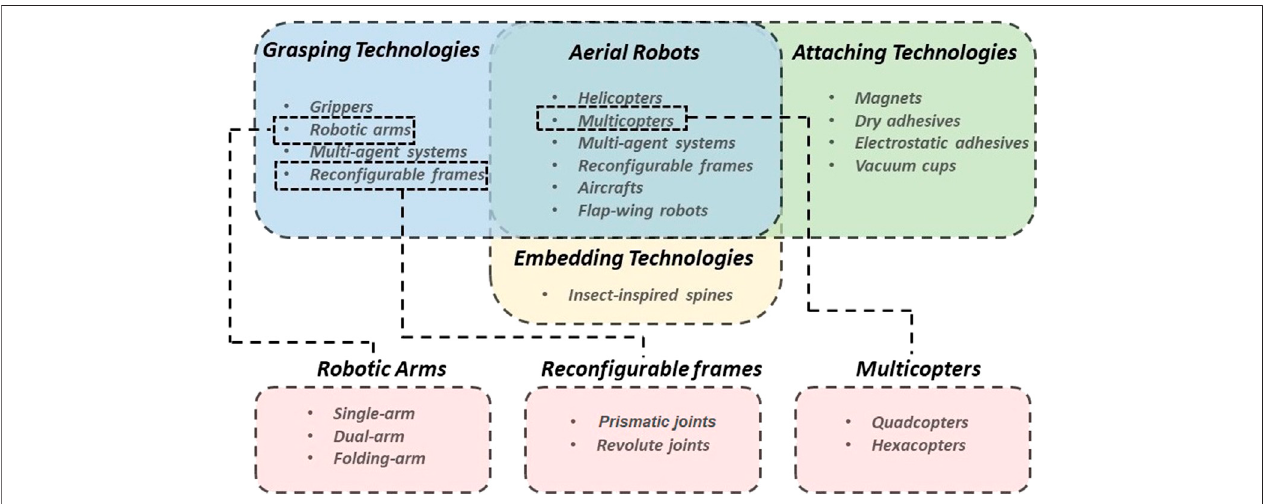
FIGURE 2 | A comparison of aerial robots with different perching technologies. As demonstrated in this fi gure, grasping technologies are highlighted in the light blue part, attaching technologies are highlighted in the light green part, and embedding technologies are highlighted in the light yellow part. Furthermore, it is worth noting that robotic arm in the grasping technologies section includes three sub-categories: single-arm, dual-arm, and folding-arm; multicopter in the aerial robots section includes two sub-categories: quadcopter and hexacopter; recon fi gurable frame in the grasping technologiessection includes two sub-categories: prismatic joint and revolute